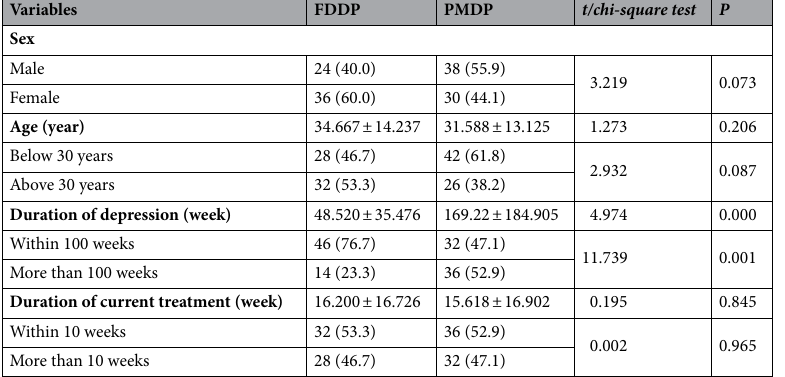
Table 1. Baseline general characteristics of FDDP and PMDP subjects. Variables are shown as N (%) and mean ± SD.